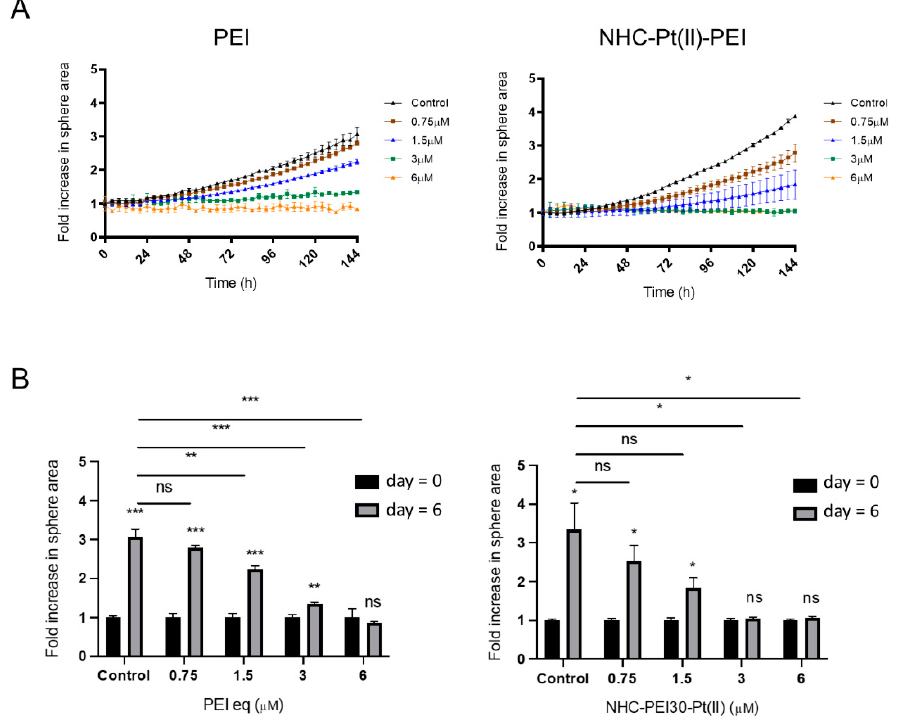
Figure 2. Effect of PEI and NHC-Pt(II)-PEI on NCH421K spheroid formation. ( A ) Scatter plots representing fold increase in spheroid area over time normalised to the time = 0 baseline. ( B ) Paired histograms showing the fold increase in area at time = 0 and time = 6 days (144 h) for each treated condition. Values represent the mean of at least n = 3 independent replicates ± one SEM. Control = ethanol vehicle control of the most concentrated condition (6 µM). Statistics above the bar charts represent Student’s t -tests carried out between time = 0 and time = day 6 values for each condition. Statistics between histograms represent Student’s t -tests of day = 6 values between conditions. ns = p > 0.05 * = p ≤ 0.05, ** = p ≤ 0.01. *** = p ≤ 0.001. Distribution normality was confirmed using a Shapiro–Wilk test. Data collected using the IncuCyte and analysed using IncuCyte Zoom software.